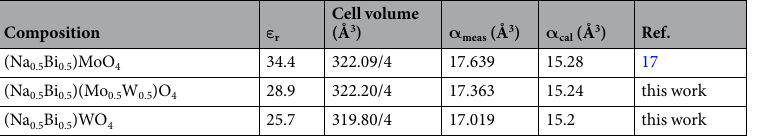
Table 3. Dielectric permittivity, cell volume, calculated and measured molecular polarizability of the (Na 0.5 Bi 0.5 ) (Mo